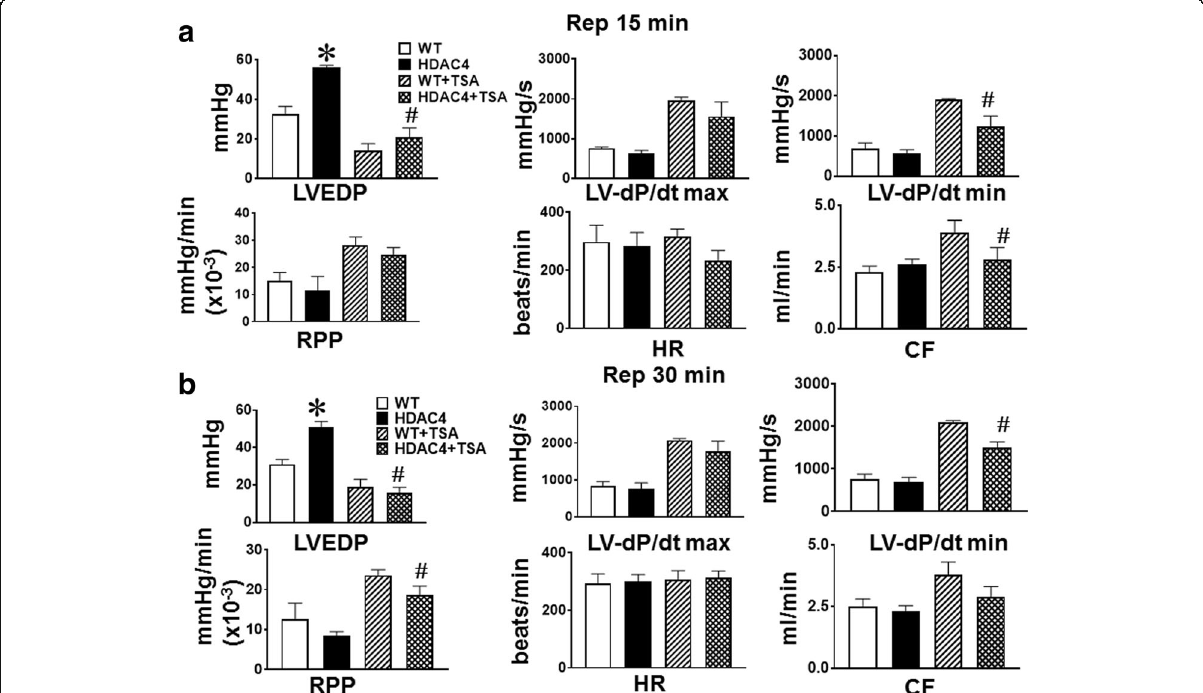
Fig. 5 Post-ischemic ventricular functional recovery following ischemia and reperfusion at the different times. a At 15 min of reperfusion; b At 30 min of reperfusion. Left ventricular (LV) function was assessed in isovolumetric hearts. The measured parameters include LV systolic pressure developed pressure (LVDP), LV-dP/dt max, LV-dP/dt min, heart rate (HR) and coronary effluents (CF). Values represent mean ± SE ( n = 4 – 5/per group), * p < 0.05 vs wild type mice; # p < 0.05 vs. α -MHC-HDAC4 mice